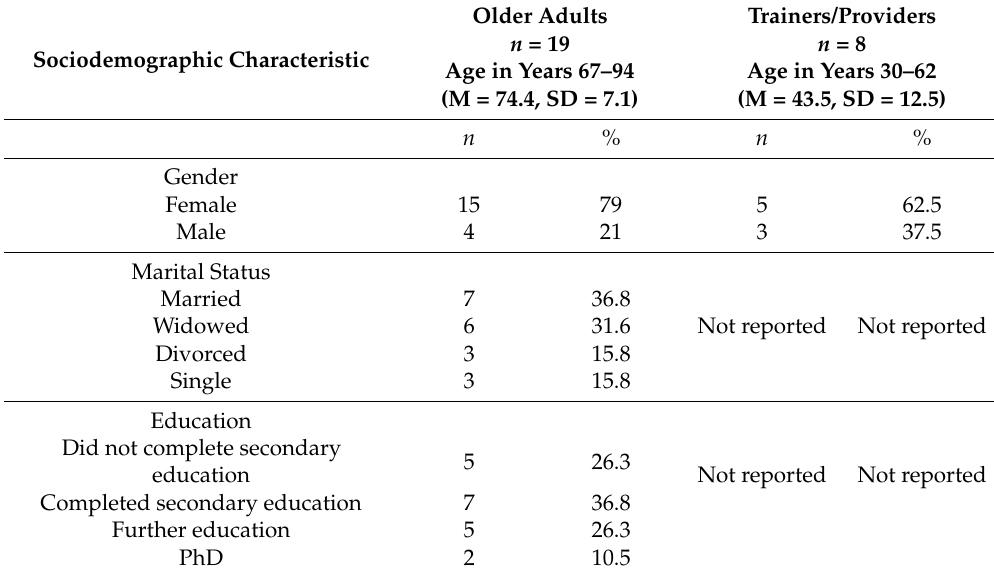
Table 1. Sociodemographic Characteristics of